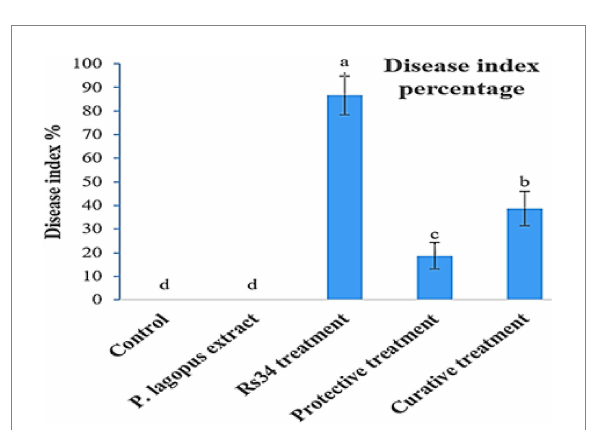
FIGURE 2 Effect of Plantago lagopus extract on disease index (DI%) of tomato root rot caused by Rhizoctonia solani under greenhouse conditions. The different letters (a–d) represent significant